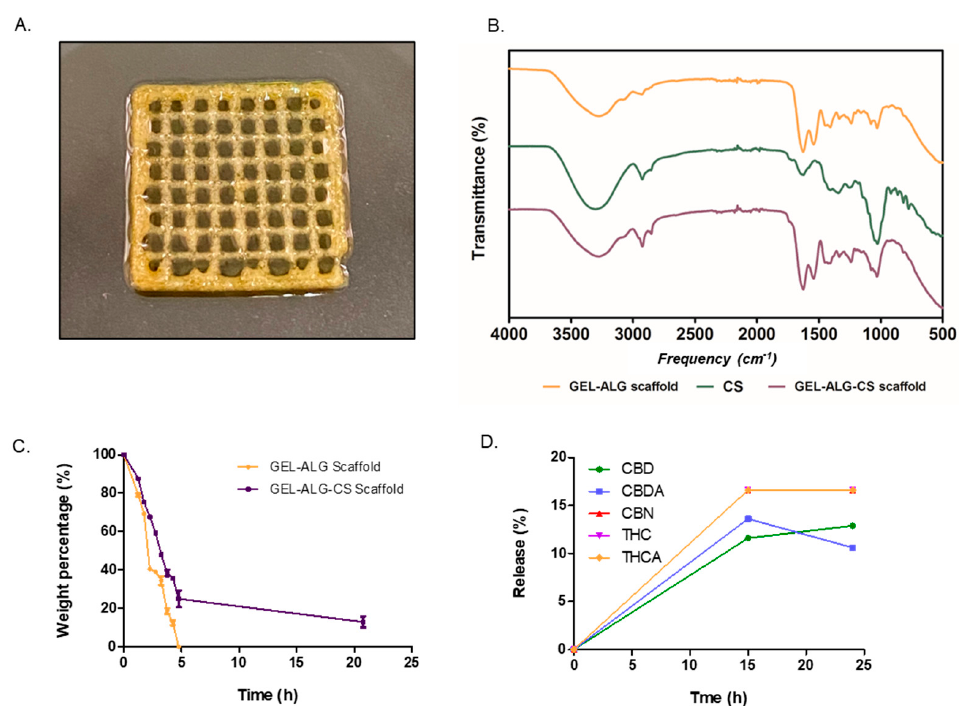
Figure 6. ( A ) Photograph of GEL–ALG scaffold loaded with Cannabis sativa oil. ( B ) FTIR ( C ) Metalloproteinase degradation of scaffolds. Variation of weight percentage with time is shown for GEL–ALG scaffold (orange) and GEL–ALG–CS scaffold (violet). ( D ) Release of Cannabis sativa oil extract. Results are expressed as mean ± SD from triplicate experiments.